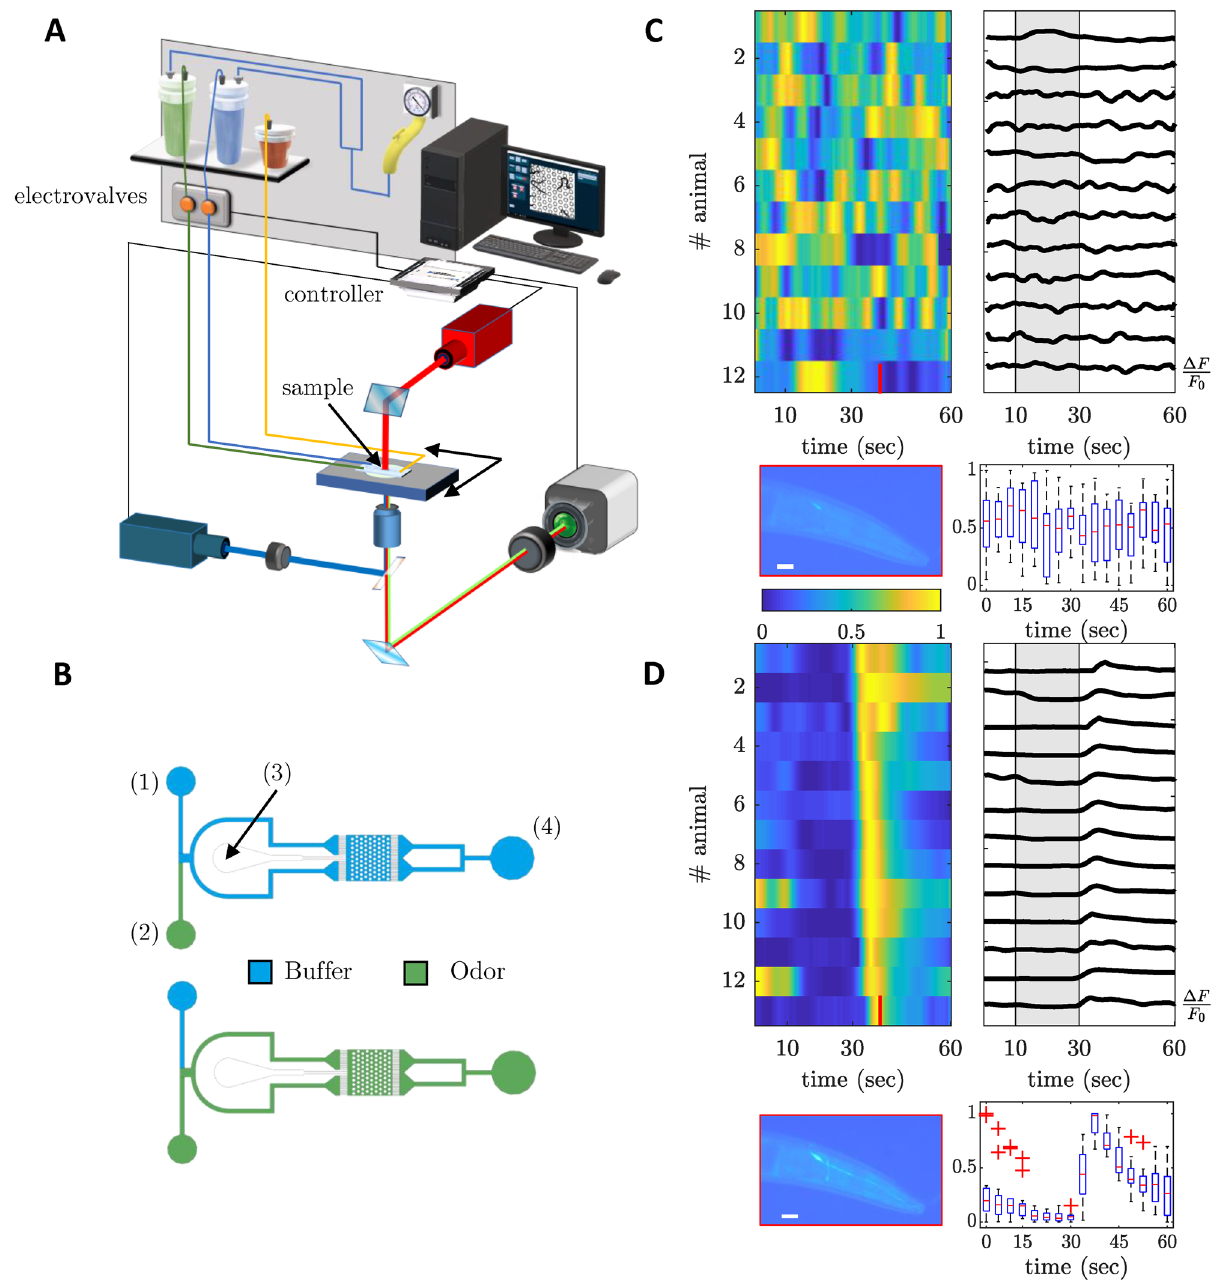
Figure 3. Wide-field imaging of neural activity upon chemical stimulation. ( A ) The sketch showing the experimental setup for simultaneous chemical stimulation via electro-valves and recording of neural responses via 470 nm blue excitation of GCaMP (blue line) and its emission (green line), and 660 nm light (red line) for transmission images. ( B ) Top view showing pulse arena geometry in two different conditions (buffer or odor filling). ( C,D ) Heatmaps and individual traces representing peak normalized neural responses ( � F / F 0 ) across 12 animals and time from ( C ) healthy donors and ( D ) cancer subjects recorded on AWC ON neuron (pictures show a crop of a wide-field 4X fluorescence image on a head with a quiescent AWC ON neuron (top) and a chemically stimulated one (bottom)). Box plots show the corresponding population average peak � F / F 0 . The central mark indicates the median, and the boxes indicate the 25th and 75th percentiles, respectively. The whiskers extend to the most extreme data points not considered outliers, and the outliers are plotted individually using the ‘+’